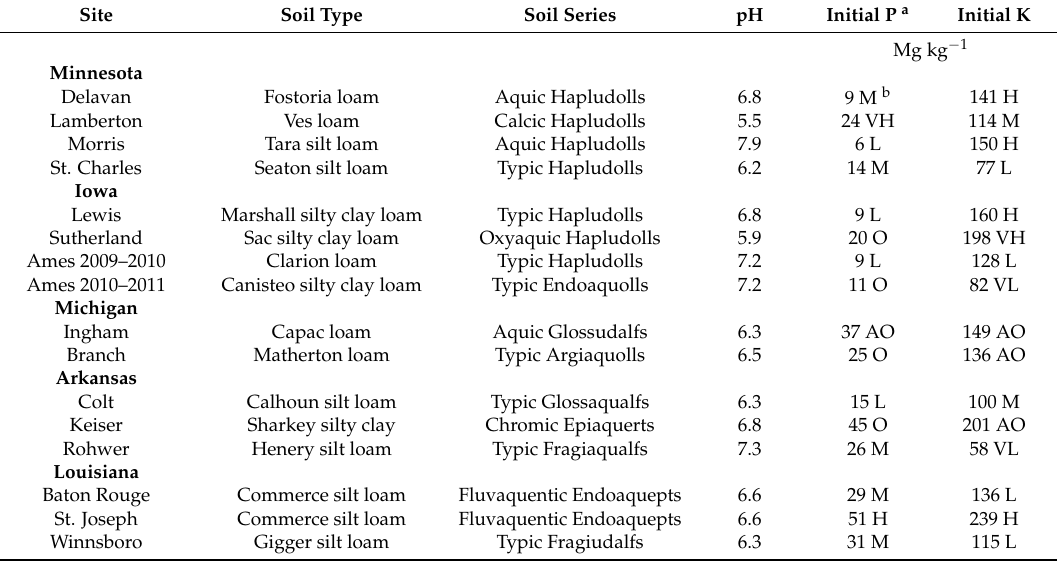
Table 1. Description of soil characteristics at research sites used in this study in the years 2009 to